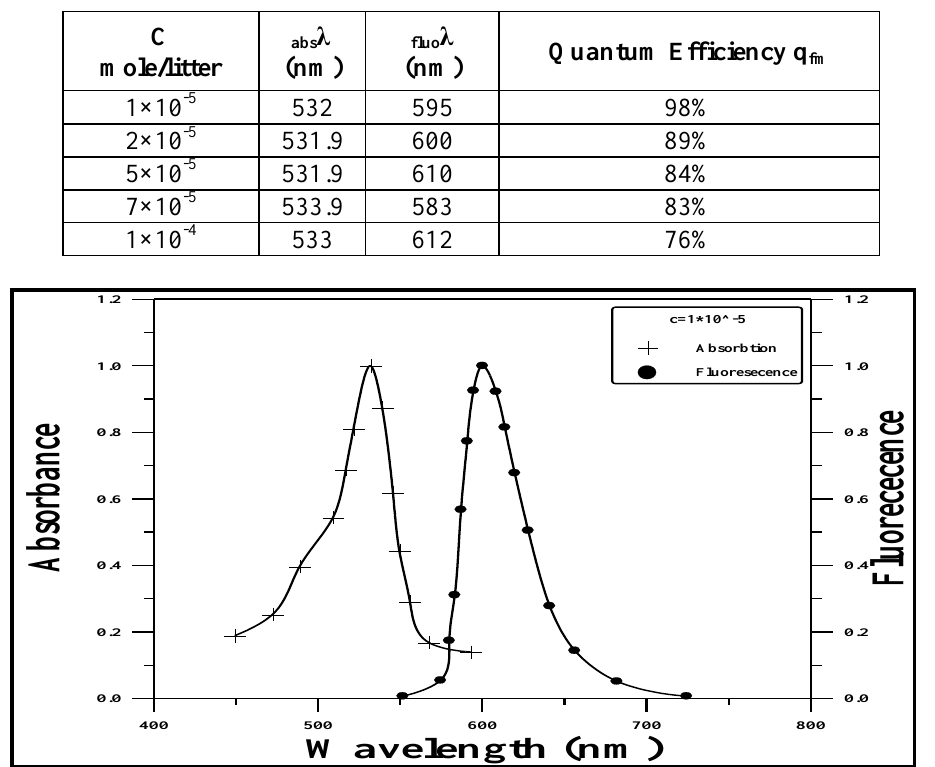
Table 1: Absorption and fluorescence peaks and the quantum efficiency of R6G.